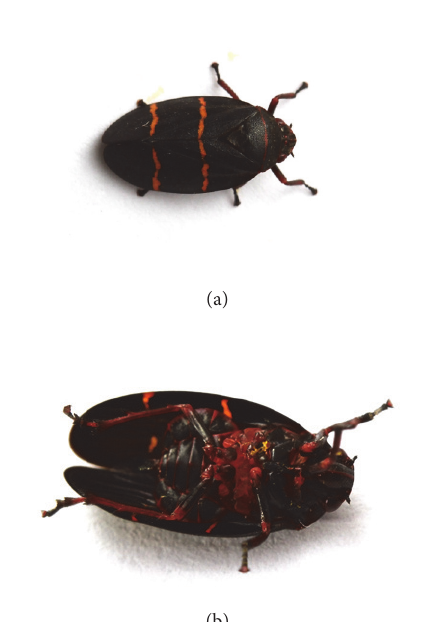
Figure 3: Prosapia bicincta : (a) dorsal view and (b) ventral view. Photographs by Brandon